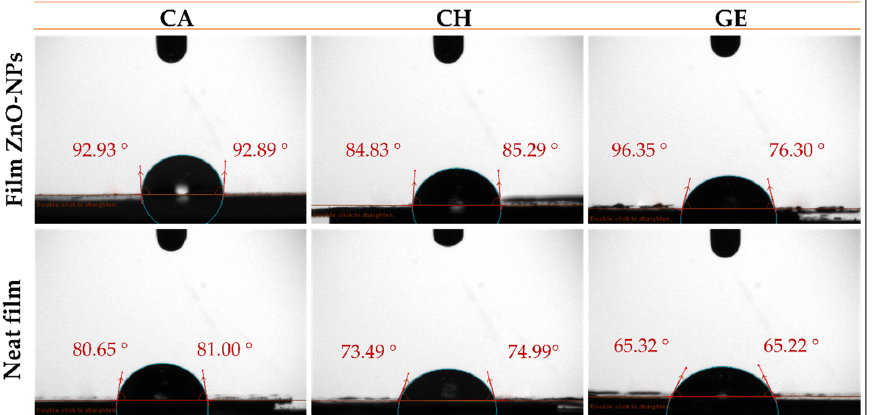
Figure 4. Water contact angle photographs of the different films reinforced with ZnO ‐ NPs (1.0% w / w ) (CA ‐ based, CH ‐ based, and GE ‐ based film ZnO ‐ NPs). Neat films without ZnO ‐ NPs (CA ‐ based, CH ‐ based, and GE ‐ based neat films) were added as reference. Table 1. Physicochemical and optical parameters of the different films reinforced with ZnO ‐ NPs (1.0% w / w ) (CA ‐ based, CH ‐ based, and GE ‐ based film ZnO ‐ NPs). Neat films without ZnO ‐ NPs (CA ‐ based, CH ‐ based, and GE ‐ based neat films) and commercial values were added as reference. The same superscript letters (a–f) in each column indicate homogeneity of variances ( p < 0.05).